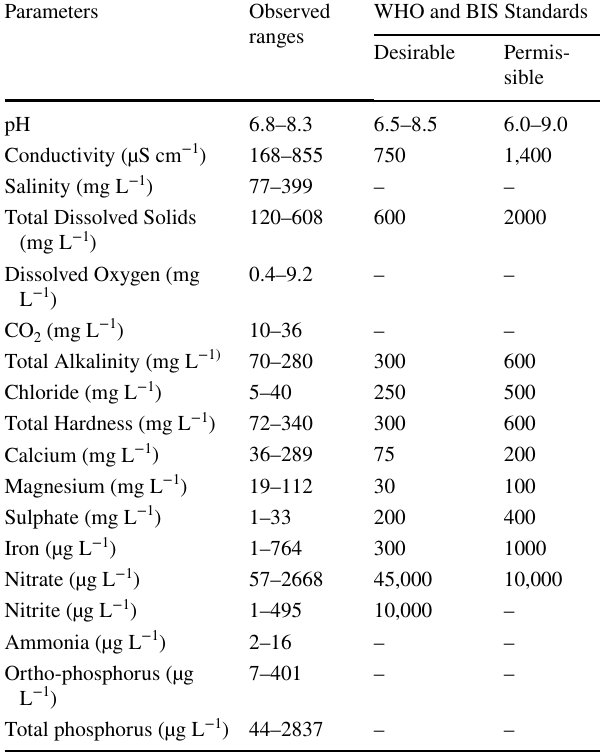
Table 2 Ranges of the various physico-chemical parameters of the spring waters collected from of Anantnag district, Kashmir Parameters Observed